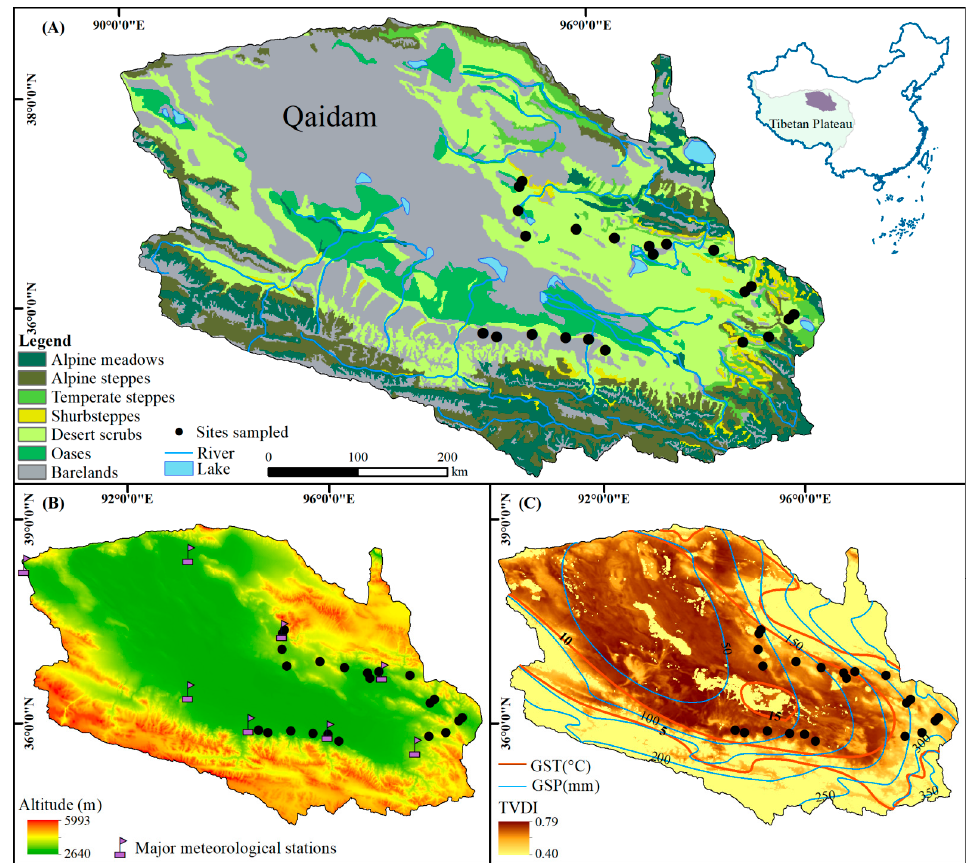
Figure 1. Vegetation ( A ), elevation and major meteorological stations ( B ), climate ( C ), and site locations (black dots) in the Qaidam Basin, Qinghai-Tibetan Plateau. In Panel C, GST and GSP refer to the average temperature and sum precipitation during the plant growing season, respectively, from May to October during 2000–2015. TVDI means the temperature vegetation dryness index.